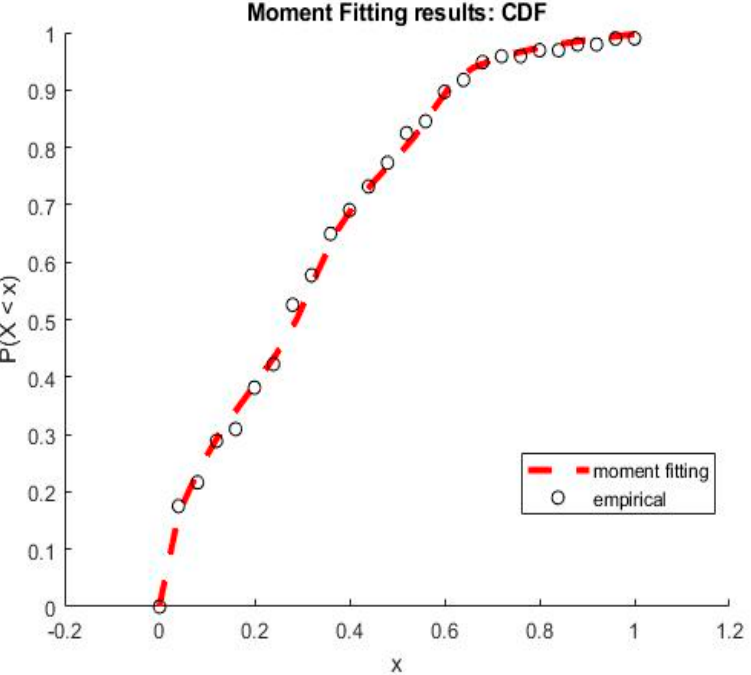
Figure 14. Estimation of the cumulative density function of the number of infected people by SARS-CoV-2 in Morocco. The results furnished by moment matching method.